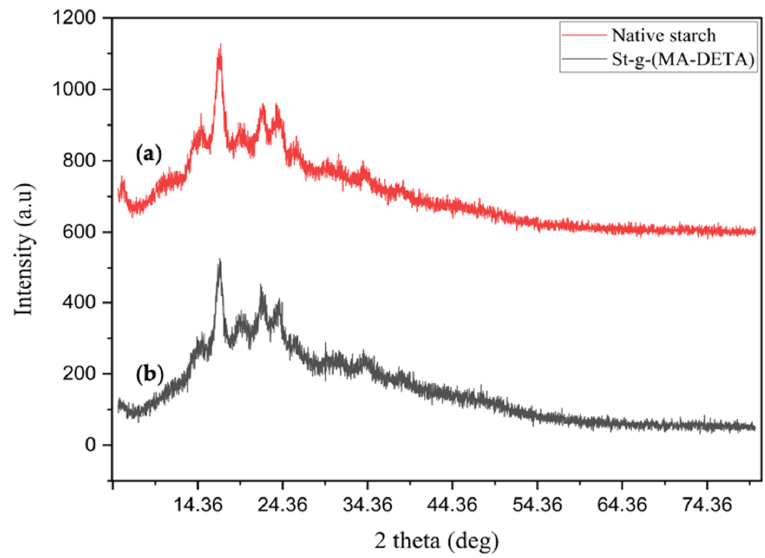
Figure 4. XRD diffraction of ( a ) starch and ( b ) St-g-(MA-DETA).